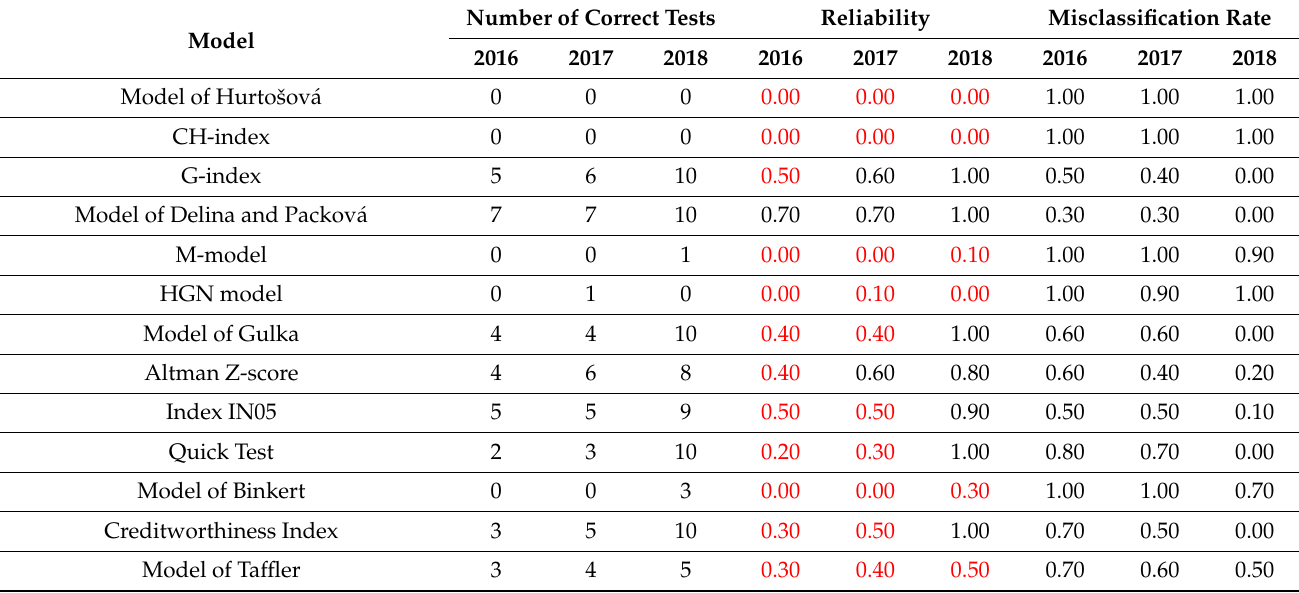
Table 9. Results of testing default prediction models on non-prosperous companies in retail sector in 2016–2018.